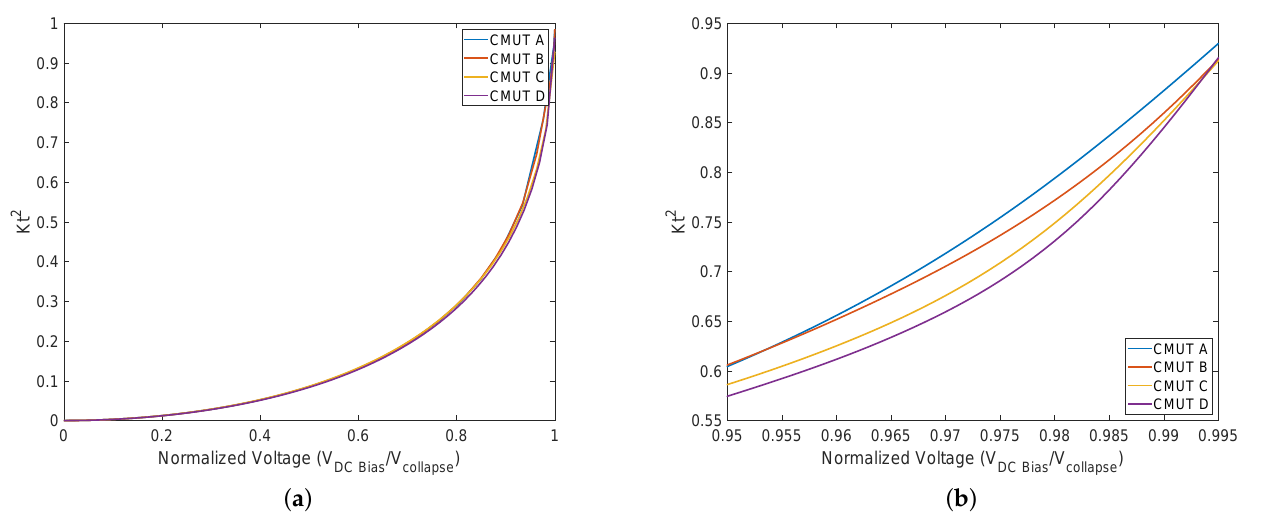
Figure 15. Electromechanical-coupling coefficient as function of voltage normalized to collapse voltage. ( a ) Electromechanical-coupling coefficient between 0–1 V normalized ; ( b ) electromechanical -coupling coefficient between 0.95–1 V normalized